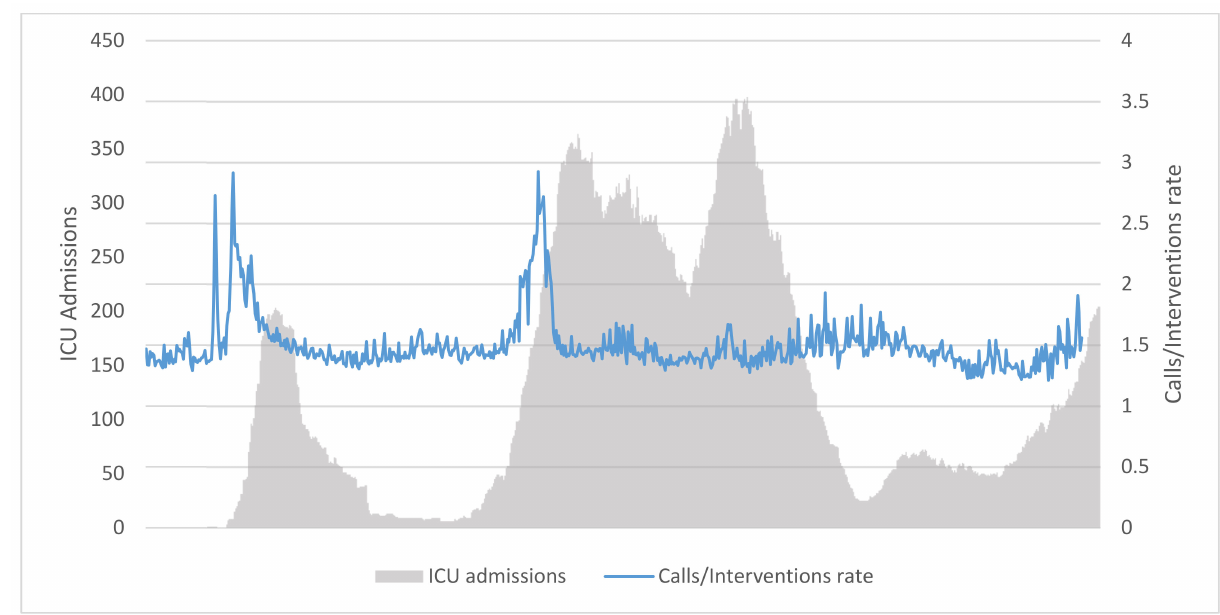
Figure 4. Calls/Interventions rate and ICU admissions in Lazio region, Italy, 2020–2021. Difference in calls number ( ∆ Calls ) in 2020 and 2021 compared to baseline (2019) has been calculated and plotted against the first order derivative D’ of ICU admissions after 7 days ( D (cid:48) ICU ). The two curves show a very similar behavior (Figure 5), tracking closely until Spring of 2021. Afterwards, their relation is still constant in regard to the direction, but the magnitude of the effect appears less evident at eye-glance. This apparent discrepancy is due both to the difference in the order of magnitude of the two curves, and in their respective meaning: ∆ Calls represents a mere number subtraction, being the difference in raw calls from previous year; D (cid:48) ICU represents the slope of ICU curve admissions, and it is more susceptible to rapid vertical change if the starting numbers are small. This means that comparative small variation in raw numbers show a higher variation in the curve slope, a phenomenon showing the same behavior in other epidemiological parameters, such as the reproduction number R [31].